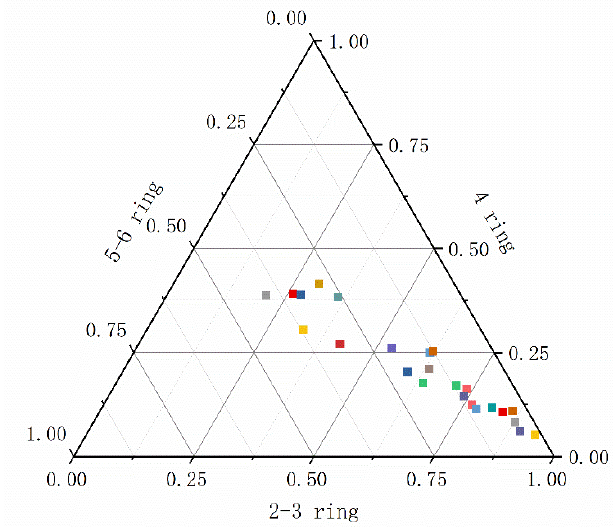
Figure 4. The composition patterns of PAHs by ring size in surface sediments samples. (2-3 rings: sum of naphthalene (Nap), acenaphthylene (Any), acenaphthene (Ana), fluorene (Flu), phenanthrene (Phe), and anthracene (Ant); 4 rings: sum of Flt, pyrene (Pyr), benz(a)anthracene (BaA), and chrysene (Chr); 5-6 rings: sum of benzo(b)fluoranthene (BbF), benzo(k)fluoranthene (BkF), benzo(a)pyrene (BaP), dibenz(a,h)anthracene (DbA), benzo(g,h,i)perylene (BghiP), and indeno (1,2,3-cd)pyrene (InP)).